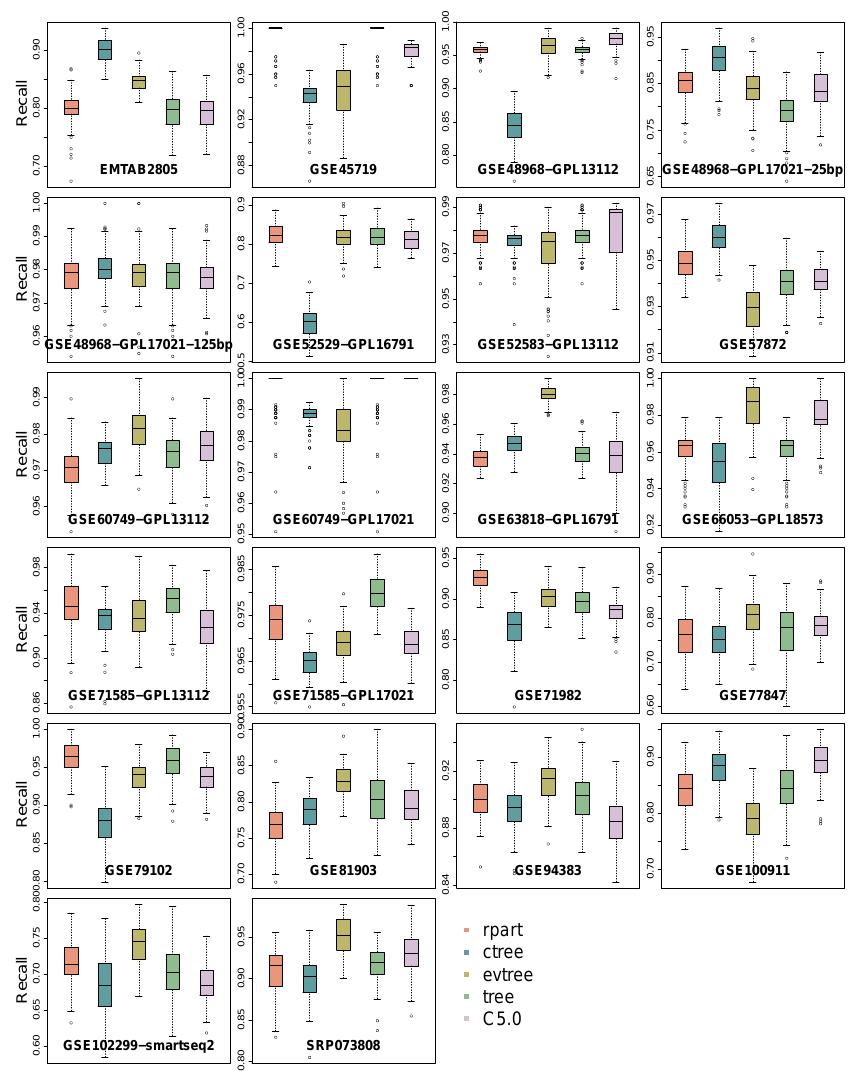
Figure 3. Methods’ Recall scores on all data sets.